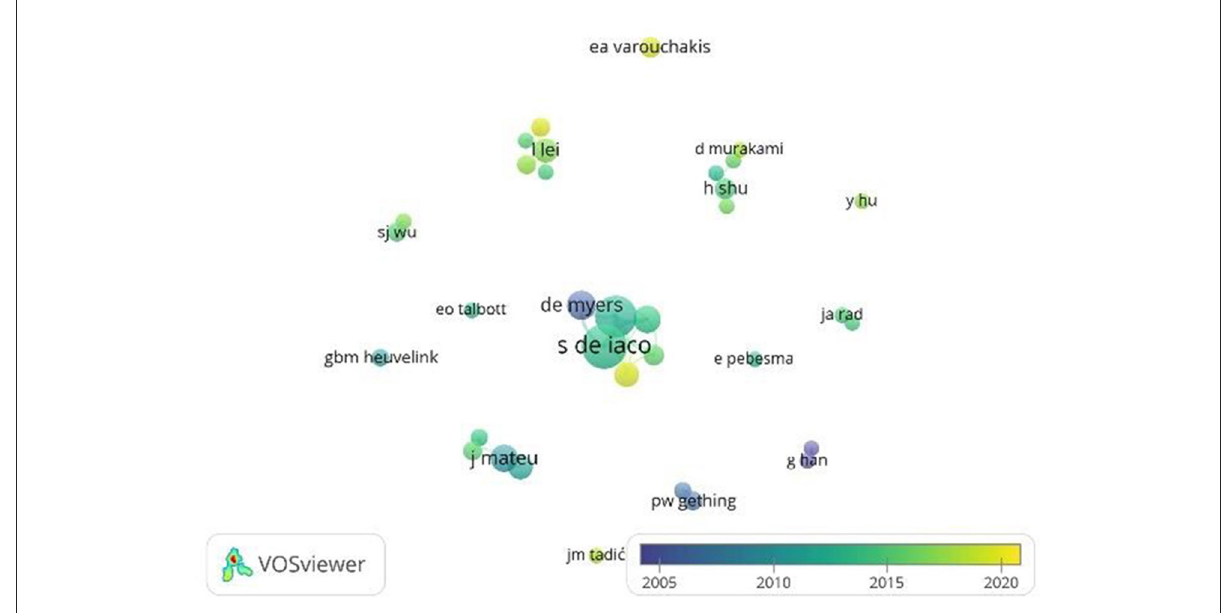
FIGURE4 Time overlay visualization of co-citation analysis.